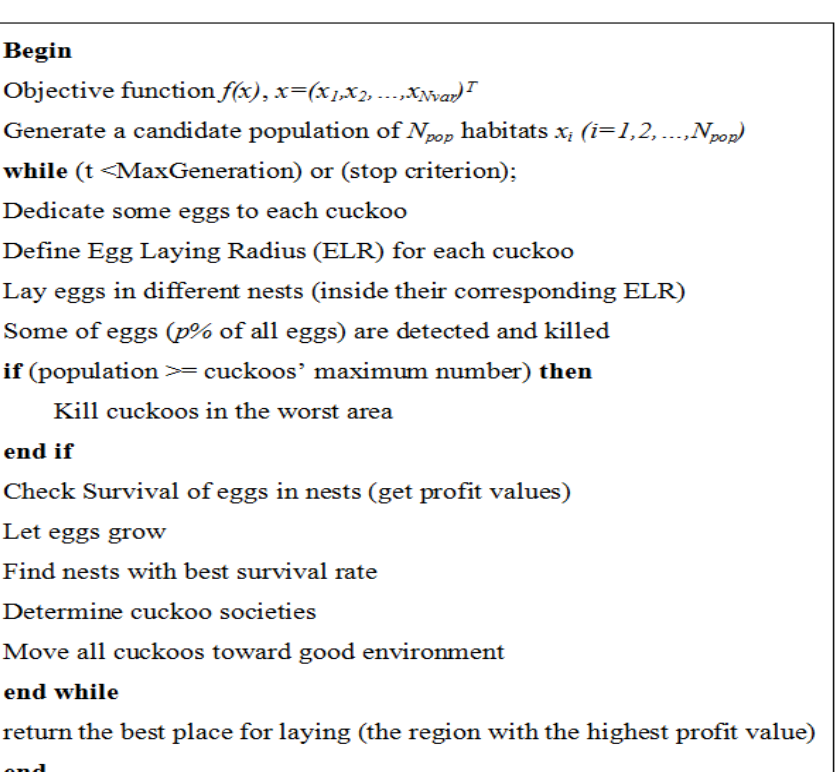
Figure 2. Pseudocode of the Cuckoo Optimization Algorithm